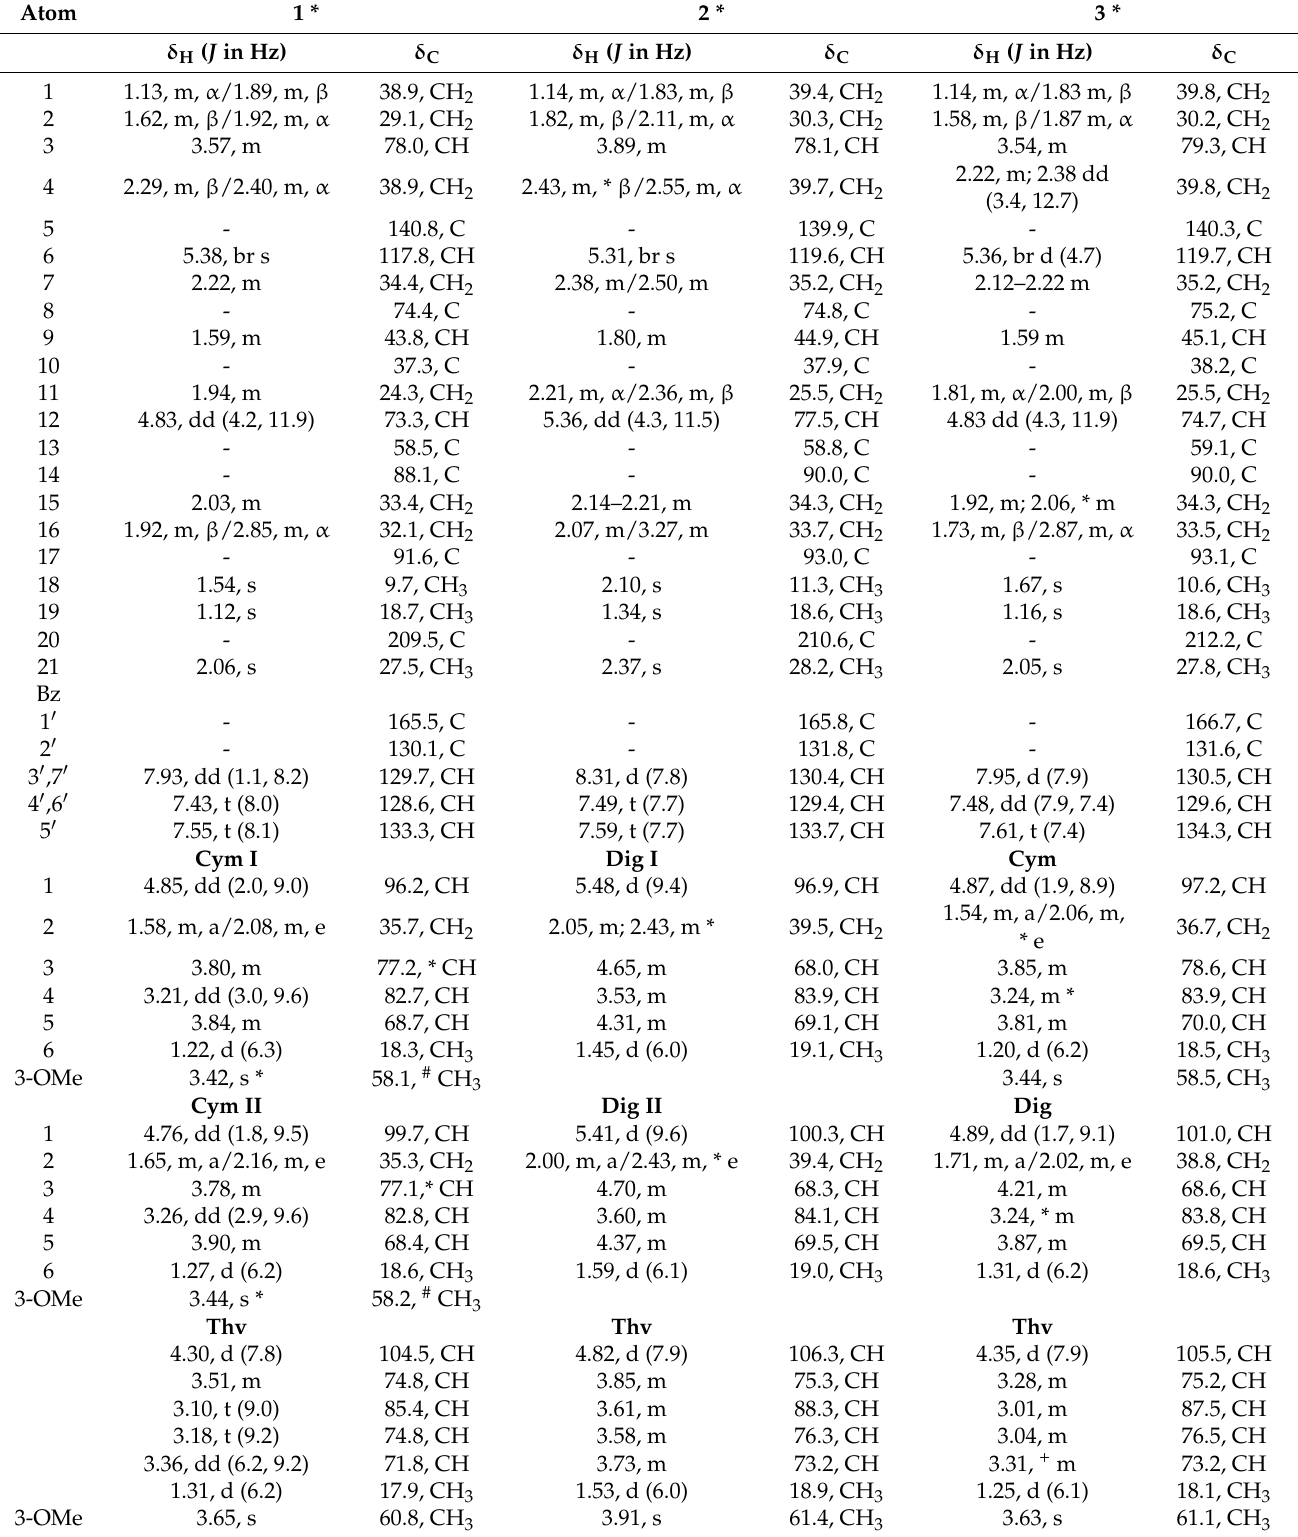
Table 1. The 1 H and 13 C NMR data for compounds 1 – 3